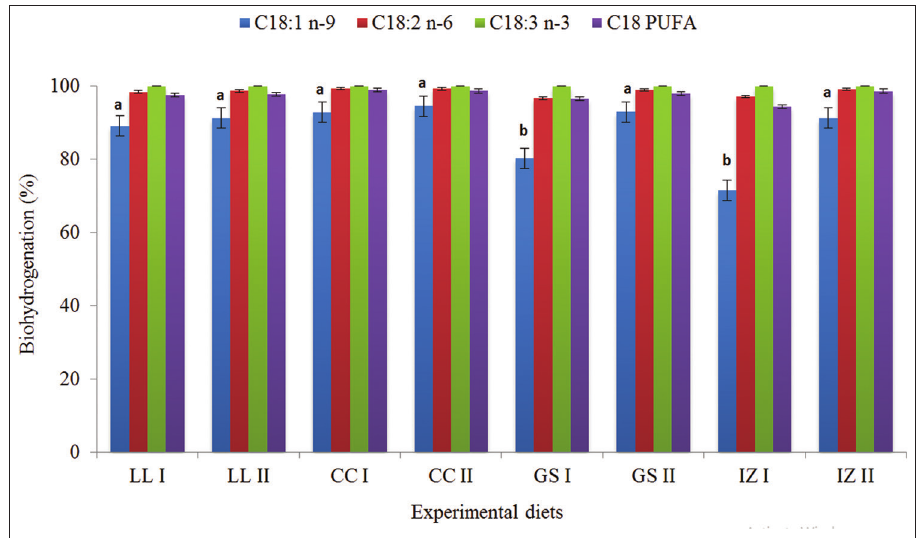
Figure-1: Biohydrogenation activity (%) among experimental diets. LL I=50% Pennisetum purpureum + 50% Leucaena leucocephala ; LL II=75% P. purpureum + 25% L. leucocephala ; GS I=50% P. purpureum + 50% Gliricidia sepium ; GS II=75% P. purpureum + 25% G. sepium ; IZ I=50% P. purpureum + 50% I. zollingeriana ; IZ II=75% P. purpureum + 25% I. zollingeriana ; CC I=50% P. purpureum + 50% Calliandra calothyrsus ; CC II=75% P. purpureum + 25% C. calothyrsus . Different superscript ( a,b ) indicate significant differences